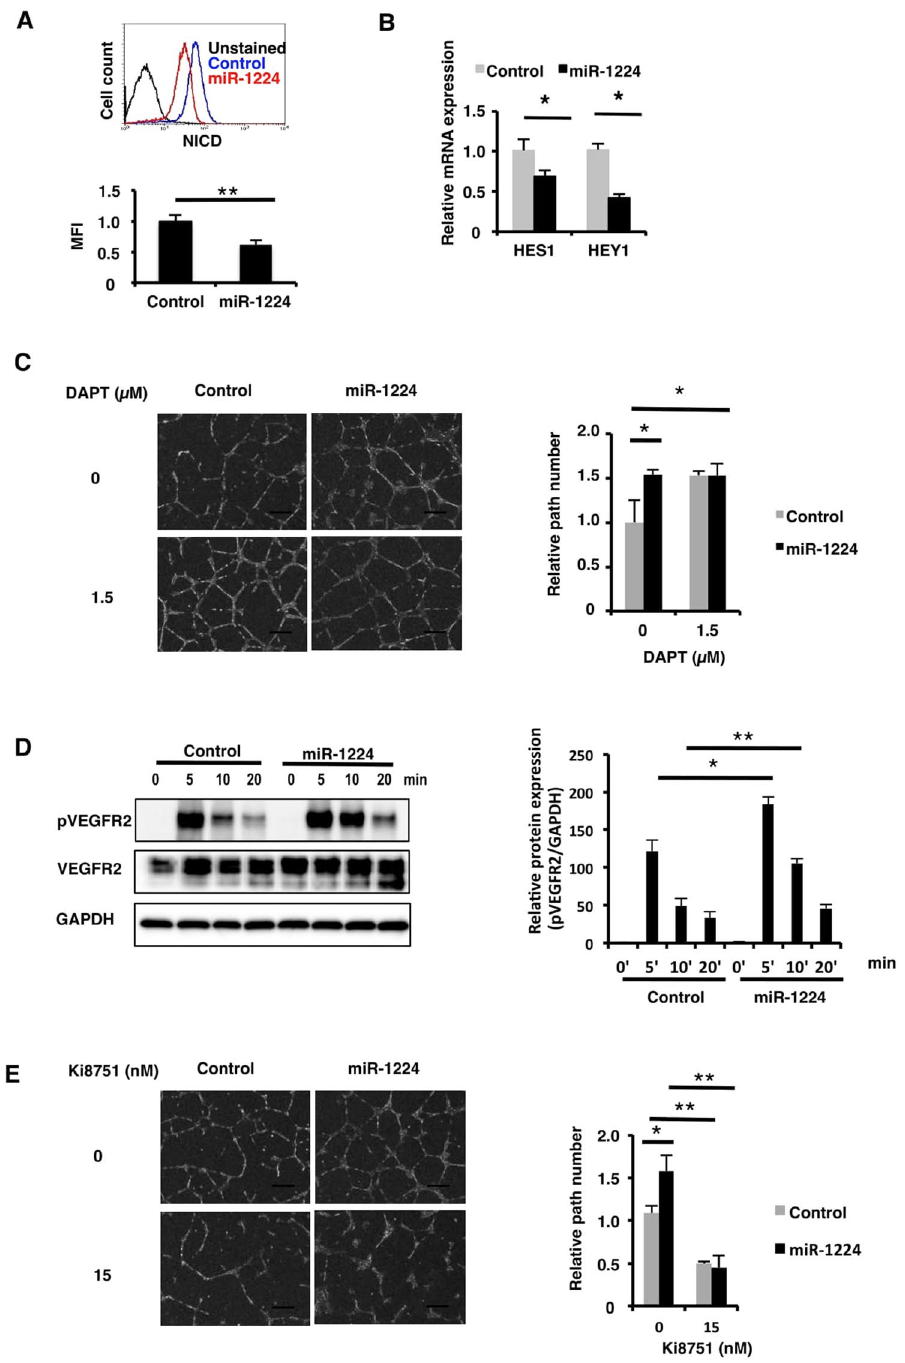
Figure 3. Reduced NOTCH signaling and elevated VEGF signaling in miR-1224–transfected HUVECs. ( A ) FACS analysis of HUVECs transfected with miR-1224 (red) or control mimic (blue) for the cleaved NICD. Unstained control (black) is shown. Mean fluorescence intensity (MFI) was calculated. Bars show the means ± S.D. with ** p < 0.01 (n = 4). ( B ) qRT-PCR analysis of HES1 and HEY1 mRNA. Relative expression to negative control mimic is shown. Bars show the means ± S.D. with * p < 0.05 (n = 3). ( C ) Tube formation assay of HUVECs transfected with miRNA mimics in the presence of NOTCH inhibitor (DAPT). Scale bars, 300 μ m. Relative number of branches is shown compared to the control mimic-transfection without inhibitor. Bars show the means ± S.D. with ** p < 0.01 (n = 3). ( D ) Western blot analysis of phosphorylated VEGFR2 in HUVECs stimulated with VEGF-A. Uncropped versions of gels are provided in Supplementary Information. Results from three independent experiments were analyzed and shown. Bars show the means ± S.E. with * p < 0.05, ** p < 0.01 (n = 3). ( E ) Tube formation assay of HUVECs transfected with miRNA mimics in the presence of VEGFR2 inhibitor (Ki18751). Scale bars, 300 μ m. Relative number of branches is shown compared to the control mimic-transfection without inhibitor. Bars show the means ± S.D. with * p < 0.05, ** p < 0.01 (n =